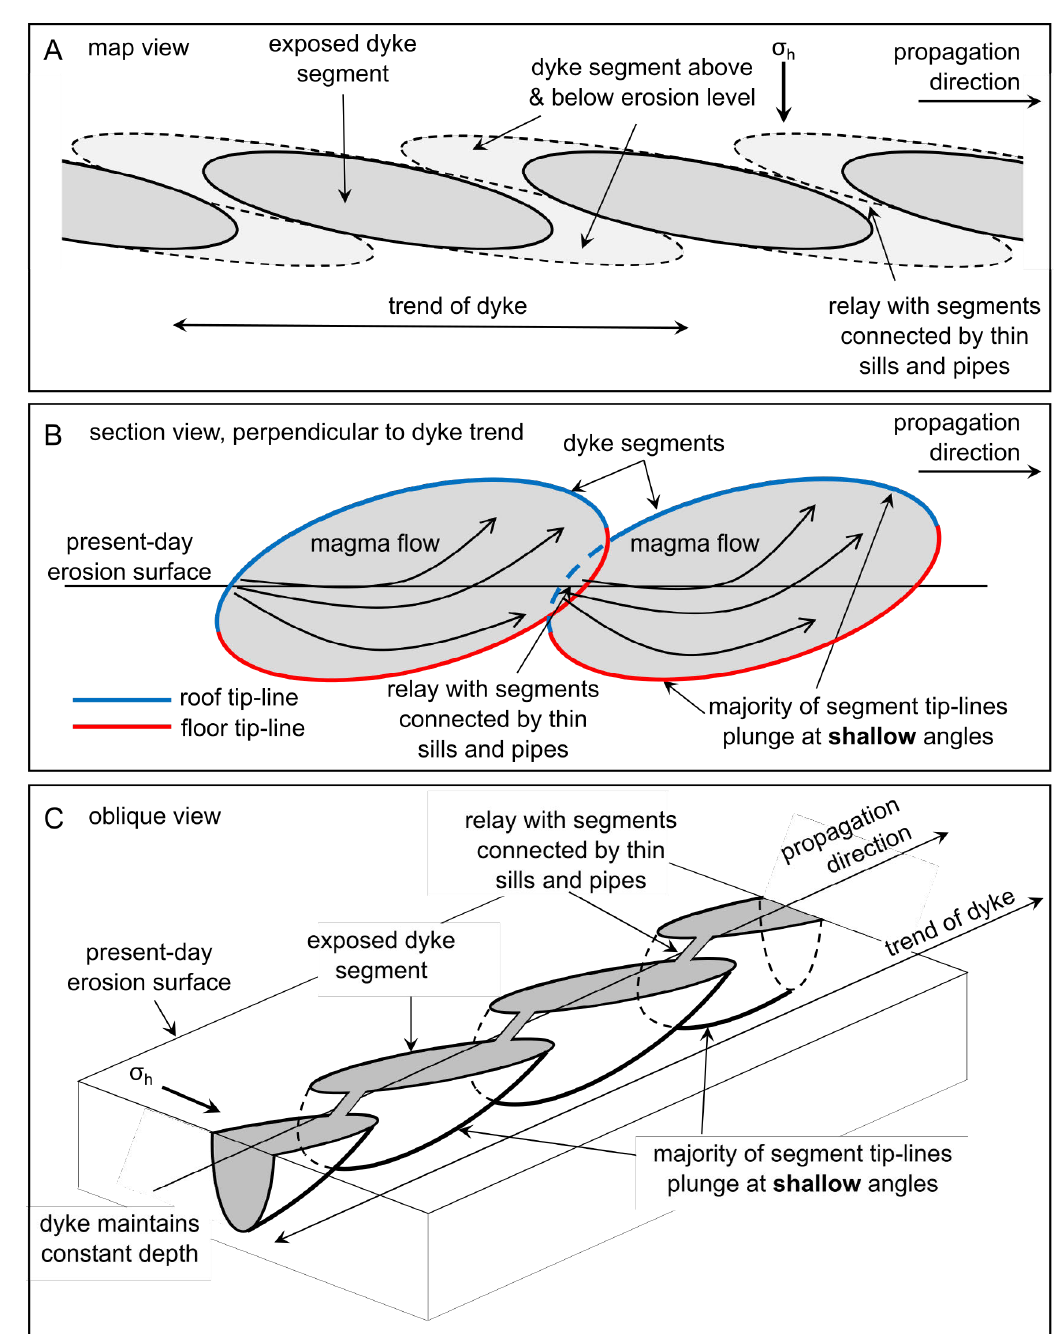
Figure 14: Summary diagrams of a new geometrical model for lateral dyke emplacement based on field evidence at Birsay. [A] Schematic map view showing discrete en echelon dyke segments (grey) and their inferred extent above and below the current exposure level (light grey). Connecting sills, dykes and pipes in the relay zones are omitted for clarity, as, based on the evidence from Birsay, they are much smaller than the segments they connect. σ h denotes the inferred orientation of the minimum horizontal stress at dyke emplacement, perpendicular to the overall dyke trend. [B] Oblique section view showing the dyke segment floor and roof tip-lines (red and blue, respectively), and their close juxtaposition in the exposed relay zone. Note that the majority of the floor and roof tip-lines plunge at shallow angles. The segment long axes are inclined to the horizontal to produce relay zones with the floor of one segment juxtaposed with the roof of the next segment. Schematic flow lines show the inferred direction of magma emplacement. [C] Schematic oblique 3D view of multiple en echelon segments and their relays. Note that the dyke is segmented over the whole vertical extent, and maintains a constant depth. σ h denotes the inferred orientation of the minimum horizontal stress at dyke emplacement, perpendicular to the overall dyke